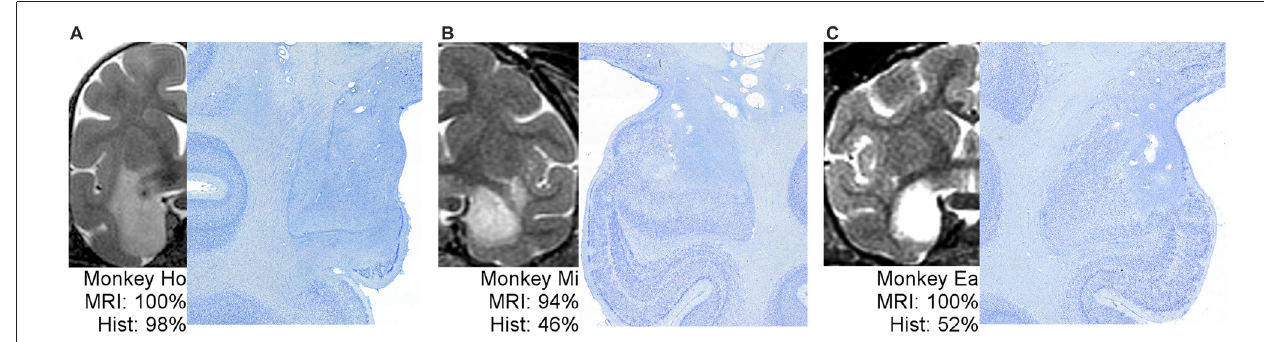
FIGURE 2 | One example of well-predicted damage (A) and two examples of poorly-predicted damage (B,C) . For each monkey, a full hemisphere of the T2 MRI scan is shown on the left, with the white hypersignal indicating potential lesion extent. The matching histological section is shown on right at higher magnification to better view the border between large, dark, healthy cells and damaged tissue. The associated percentages indicate the coded damage level throughout the entire amygdala.